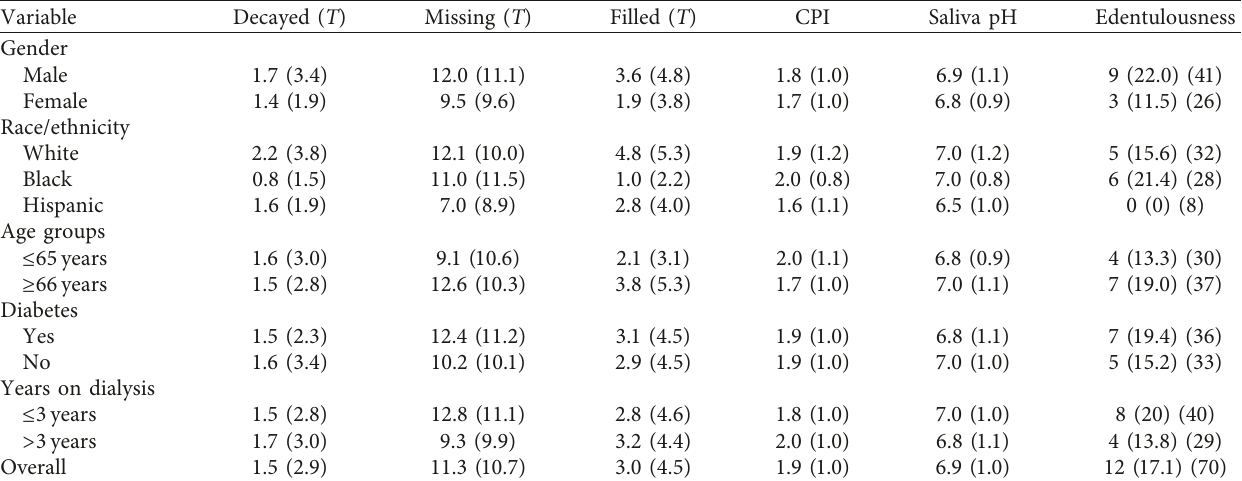
Table 3: Mean and standard deviations of decayed, missing, filled teeth index, CPI, and saliva PH across demographic and clinical characteristics of study participants and number and percentage (in parentheses) of edentate patients followed by the total number ( n ) of participants in that